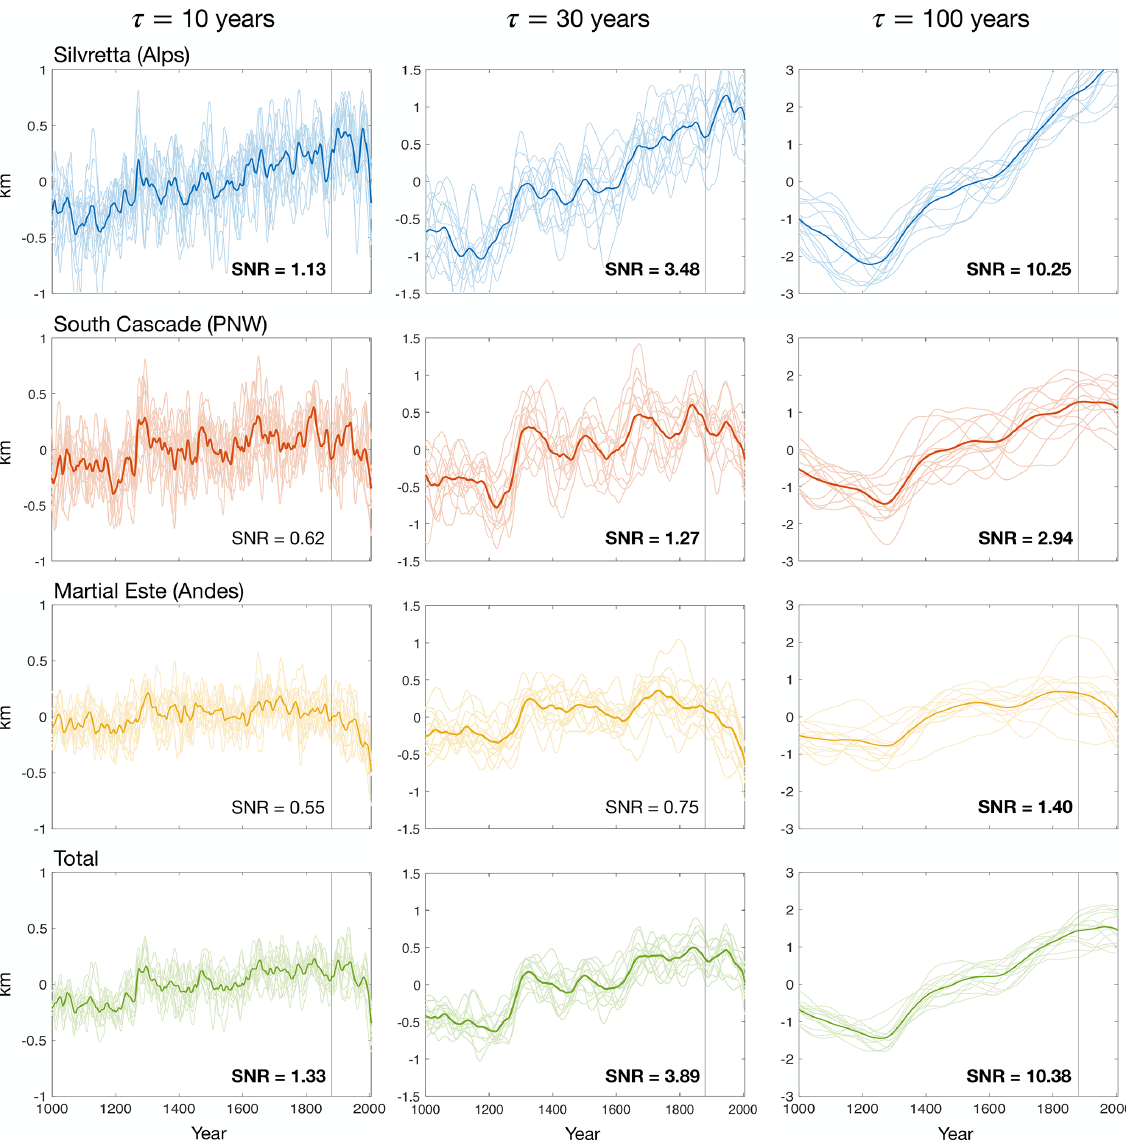
Figure 2. Simulated glacier-length anomalies for representative glaciers in the Alps (top row), the Pacific Northwest (second row), and the Patagonian Andes (third row). The fourth row shows the sum of all three glaciers. Each column shows results for different glacier response times: τ = 10 years (left), τ = 30 years (middle), and τ = 100 years (right). Heavy colors represent the ensemble mean, while lighter colors represent individual ensemble members. The vertical gray line at the year 1880 approximately marks the transition from the pre-industrial era to the modern era. SNR values are computed over the pre-industrial era only. Bold font indicates SNR > 1, meaning that the forced signal exceeds the noise of internal